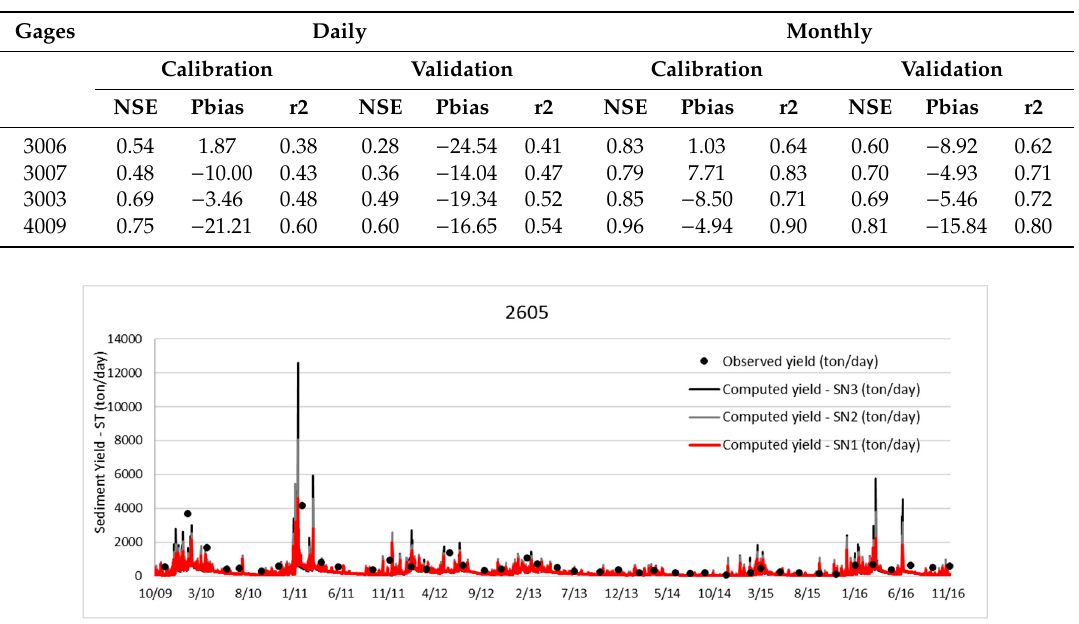
Figure 5. Performance of SWAT model for sediment yield at monitoring station 2605. Table 7. Statistic evaluation of simulated versus observed sediment yield, total nitrogen and phosphorus load.